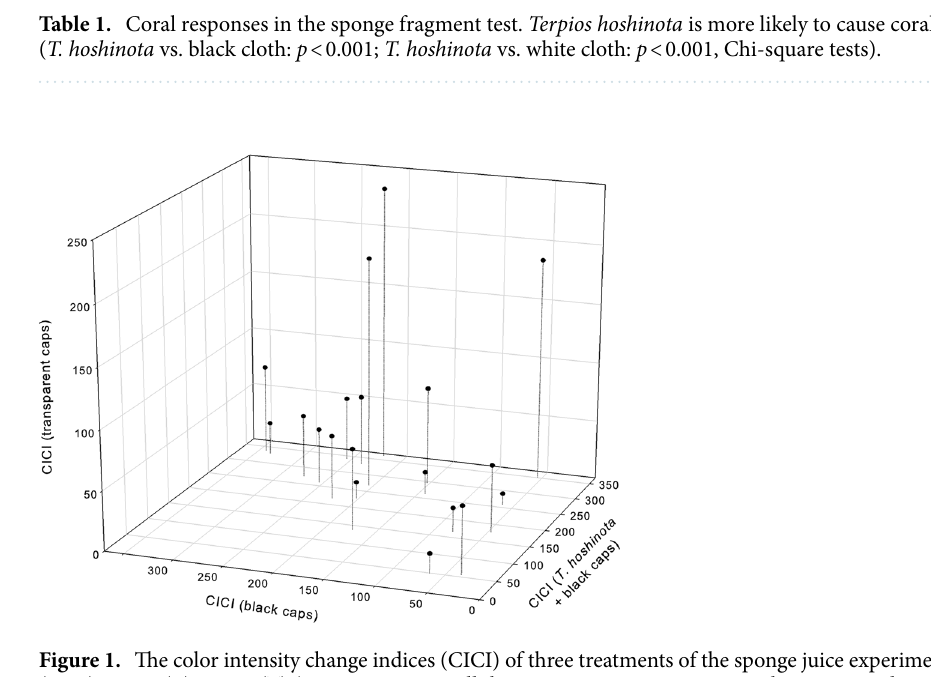
Figure 1. The color intensity change indices (CICI) of three treatments of the sponge juice experiment. CICI (S + B) > CICI (B) > CICI (T) (n = 19, p < 0.01 in all three pair-wise comparisons, Wilcoxon Signed Rank Tests). S: Sponge, B: Black caps, T: